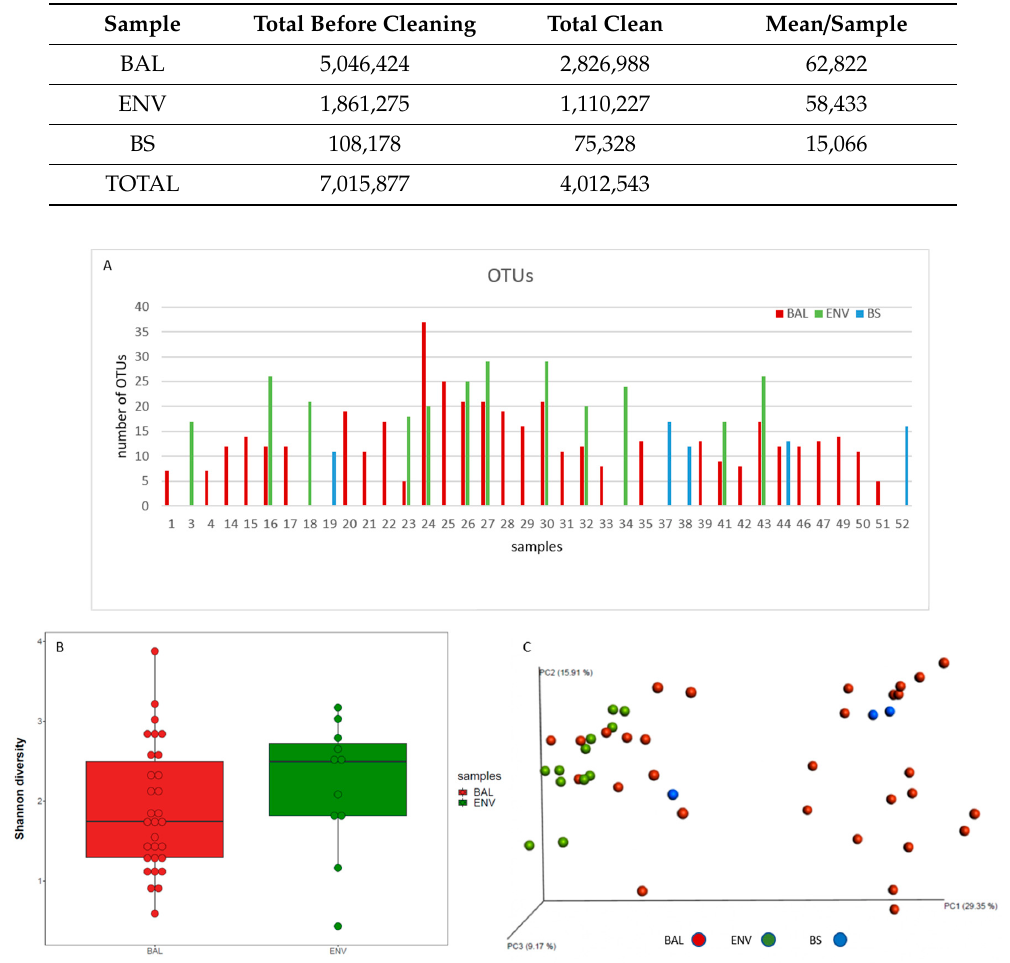
Figure 2. Fungal diversity in the studied simples. ( A ) Representation of the number of different OTUs detected in each sample. ( B ) Shannon-Wiener value for BAL and ENV samples. ( C ) Beta diversity. Bray-Curtis dissimilarity coefficient scores PCoA.